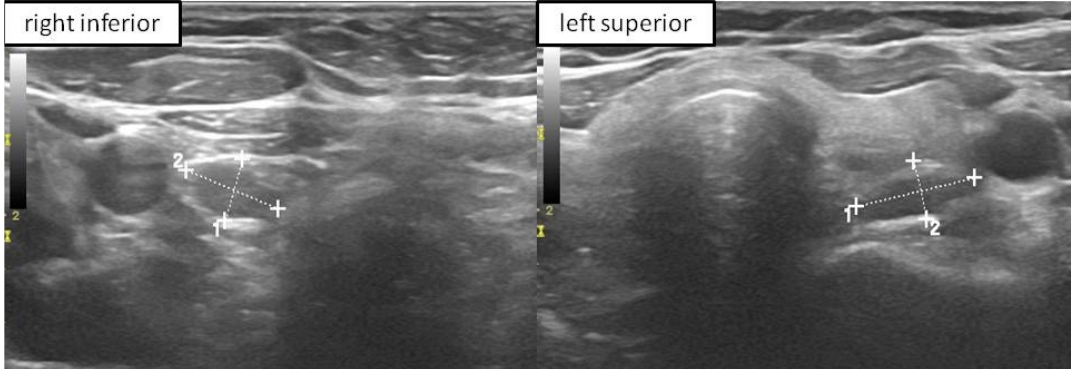
Figure 4. US of the patient with two enlarged PGs (confirmed with high iPTH ‐ WC) i.e., right inferior and left superior (marked with measuring lines).